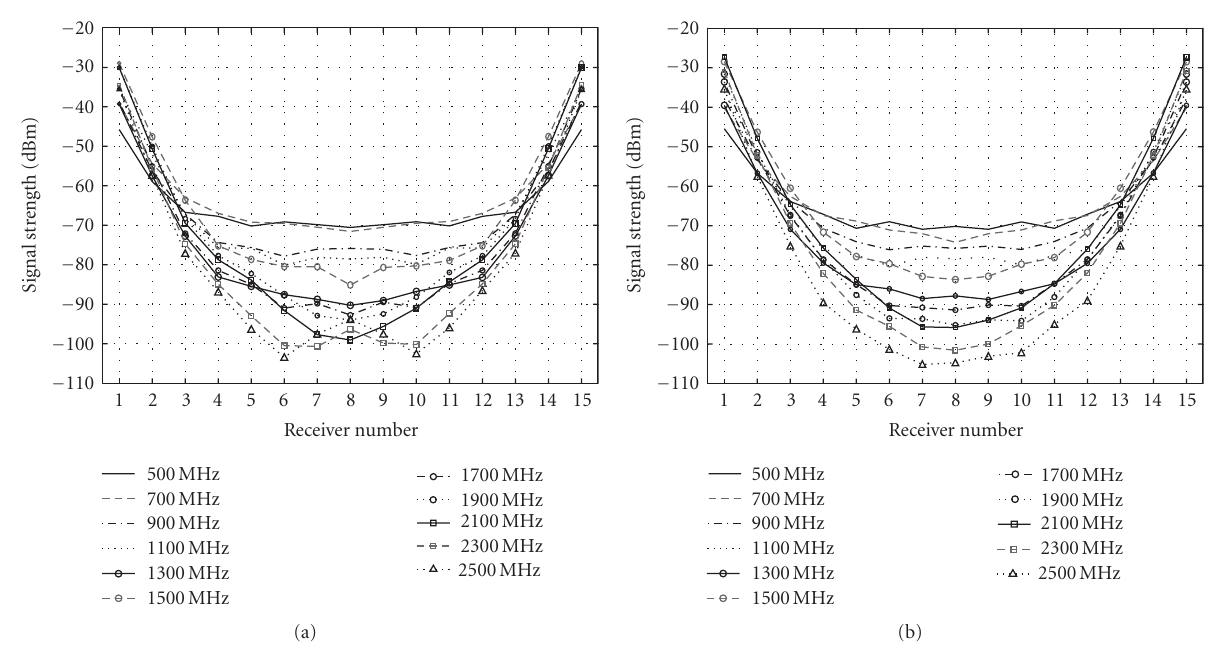
Figure 11: Plots of the transmitted signal strength as a function of receiver number over the frequency range of 500–2500 MHz for the 2.0 cm length antennas with their centers submerged (a) 2.0 cm and (b) 6.5cm below the 90% glycerin coupling liquid surface, respectively.